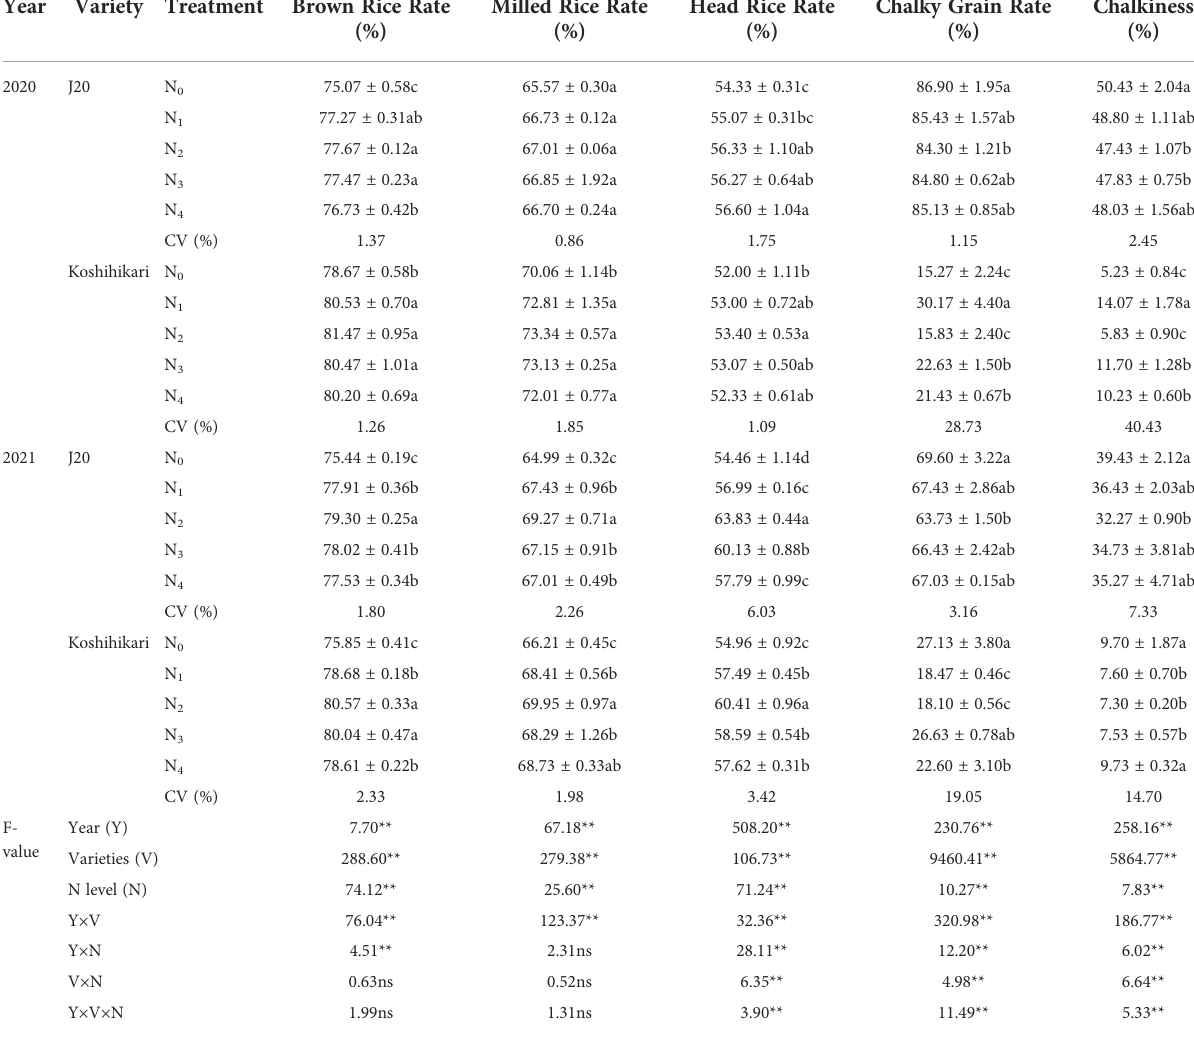
TABLE 3 Effects of N application rate on processing quality and appearance quality of rice. Year Variety